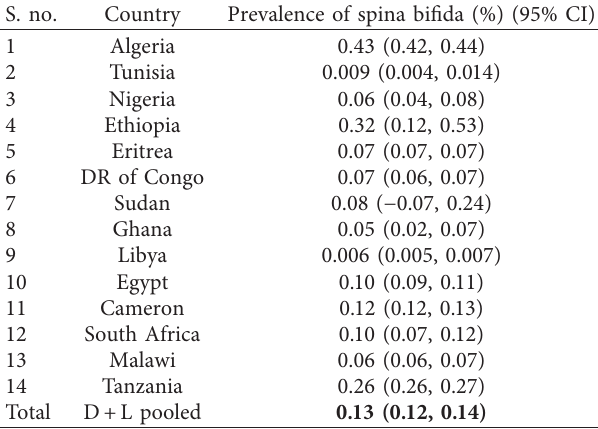
Table 2: The pooled prevalence of spina bifida among African countries,